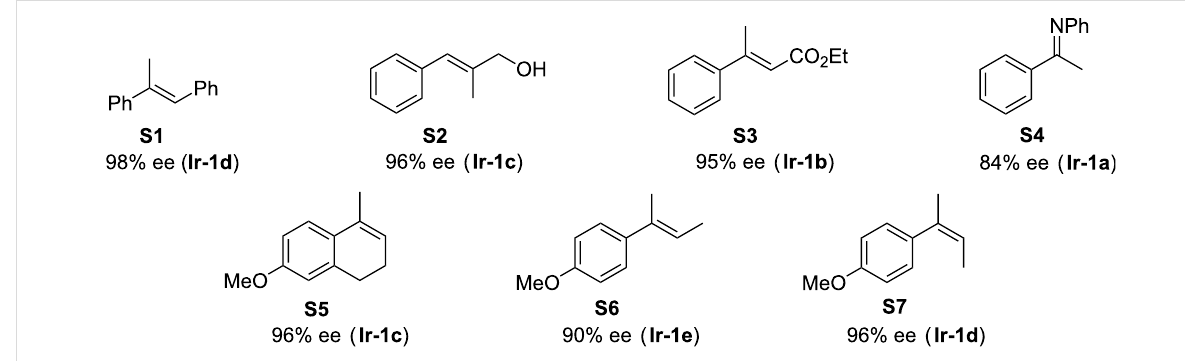
Figure 2: Asymmetric hydrogenation with iridium-NeoPHOX catalysts [19].